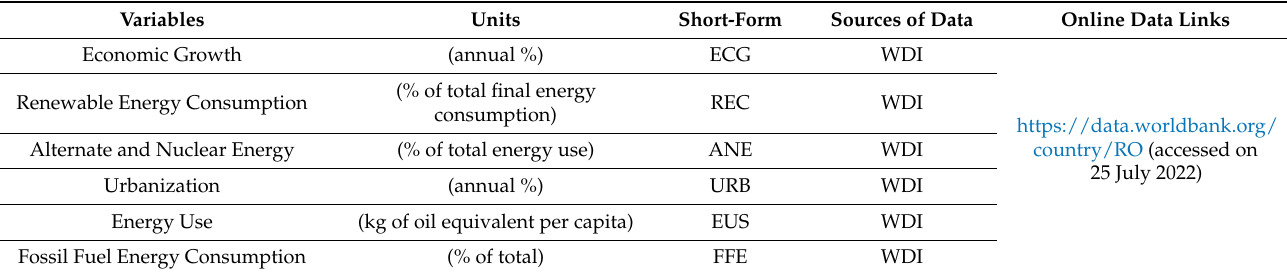
Table 3. Description of the study variables.